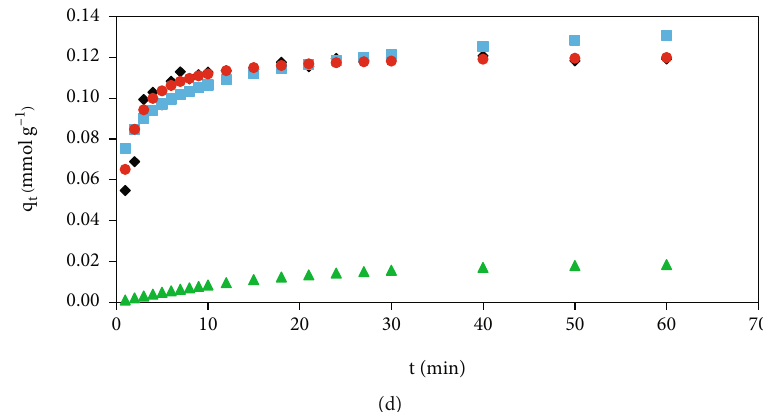
Figure 2: The linear plots of (a) pseudo- fi rst-order, (b) pseudo-second-order, and (c) Elovich models and (d) comparison of kinetics simulation plots for the experimental data (black diamond), Elovich (blue square), pseudo- fi rst-order (green triangle), and pseudo- second-order (red circle) models (mass of adsorbent = 0 : 020 g; dye volume = 10 : 0 mL; concentration of MV = 100 mgL -1 ). Table 1: Comparison of the pseudo- fi rst-order, pseudo-second-order, and Elovich models and their error values of linear analyses. Kinetics model and parameters Values